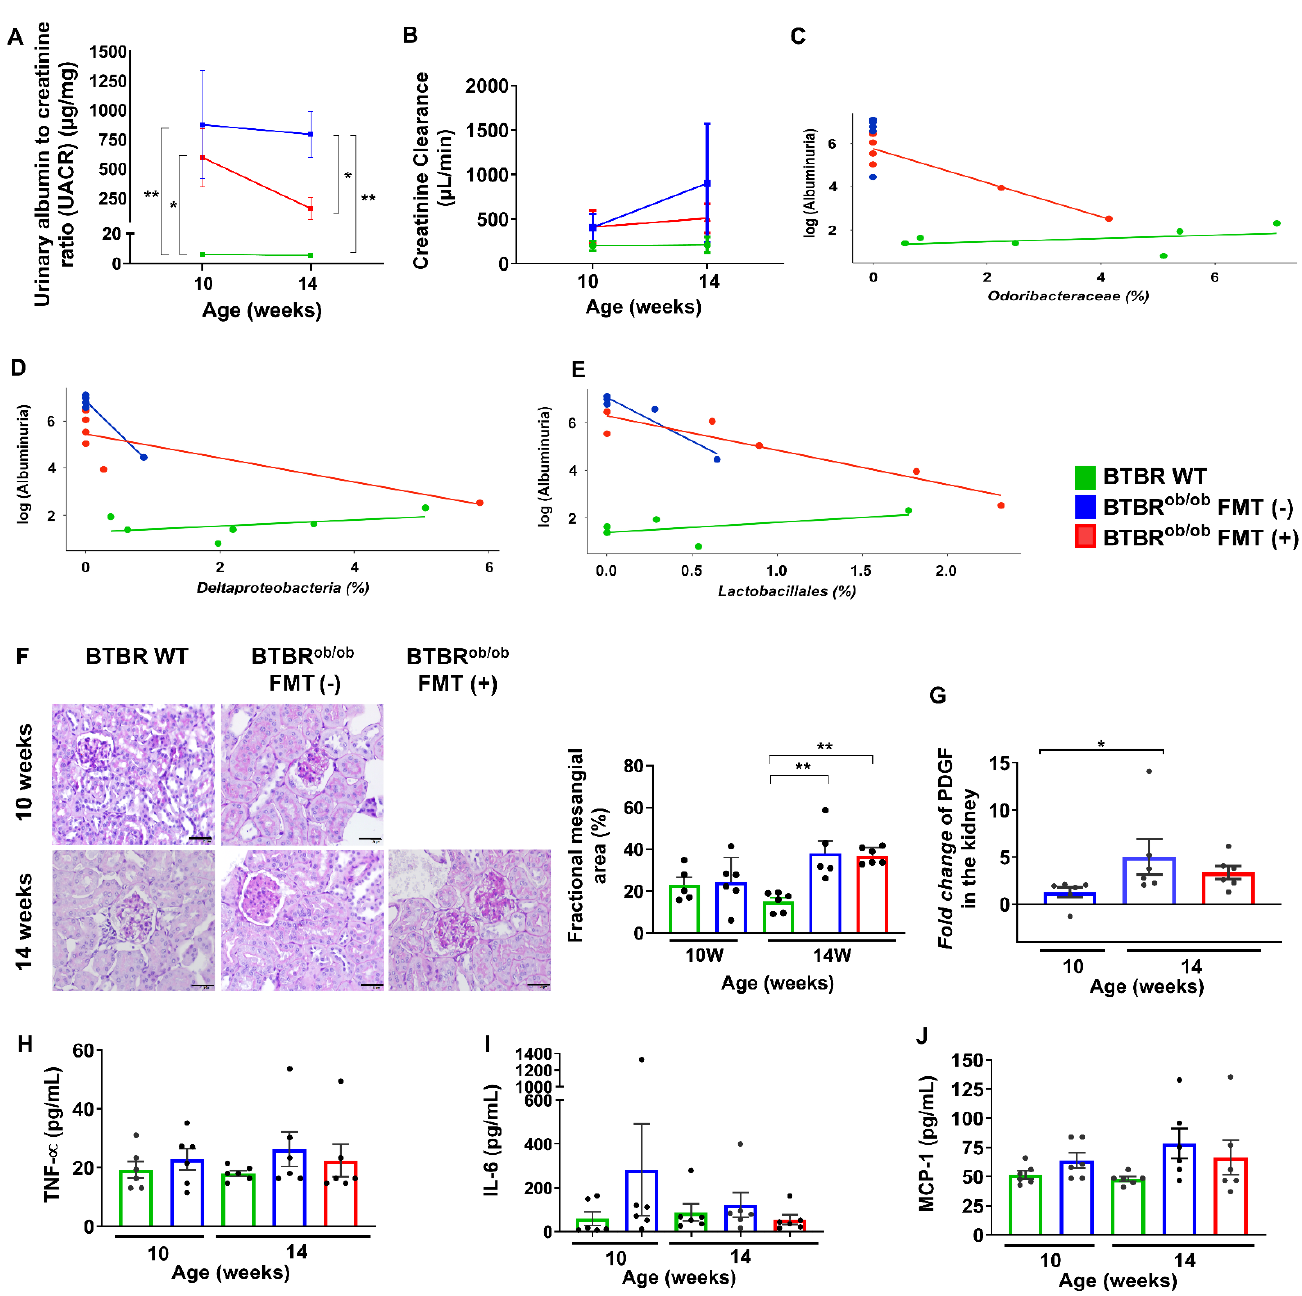
FMT (+) mice, UACR was correlated negatively to the Lactobacillales order (r = − 0.9, p = 0.02 and r = − 0.89, p = 0.04, respectively) (Figure 4E).